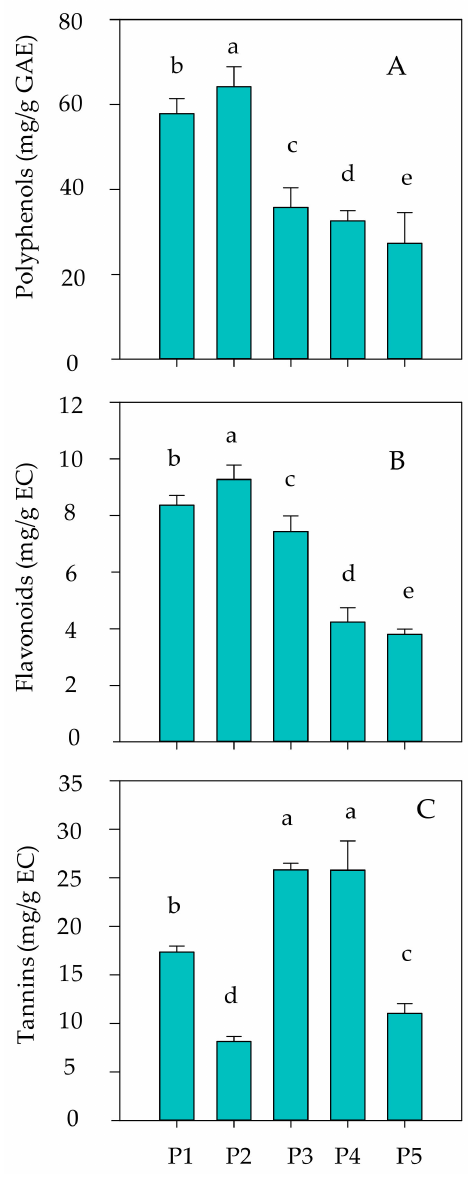
Figure 1. Total phenols (mg GAE/gDW; ( A )), flavonoids (mg CE/gDW; ( B )) and tannins (mg CE/gDW; ( C )) content in P1 (Pistacia lentiscus ), P2 (Rosmarinus officinalis ), P3 (Erica multiflora ), P4 (Calicotome villosa ) and P5 (Phillyrea latifolia ) ethanolic extracts. Means of three replicates are reported ( ± SD). Significant differences are detected in the bars ( p < 0.05), Duncan’s test. The letters (a–e) denote significant ( p < 0.05) difference between means. Table 1. Antioxidant activities of Pistacia lentiscus , Rosmarinus officinalis , Erica multiflora , Calicotome villosa , and Phillyrea latifolia ethanolic